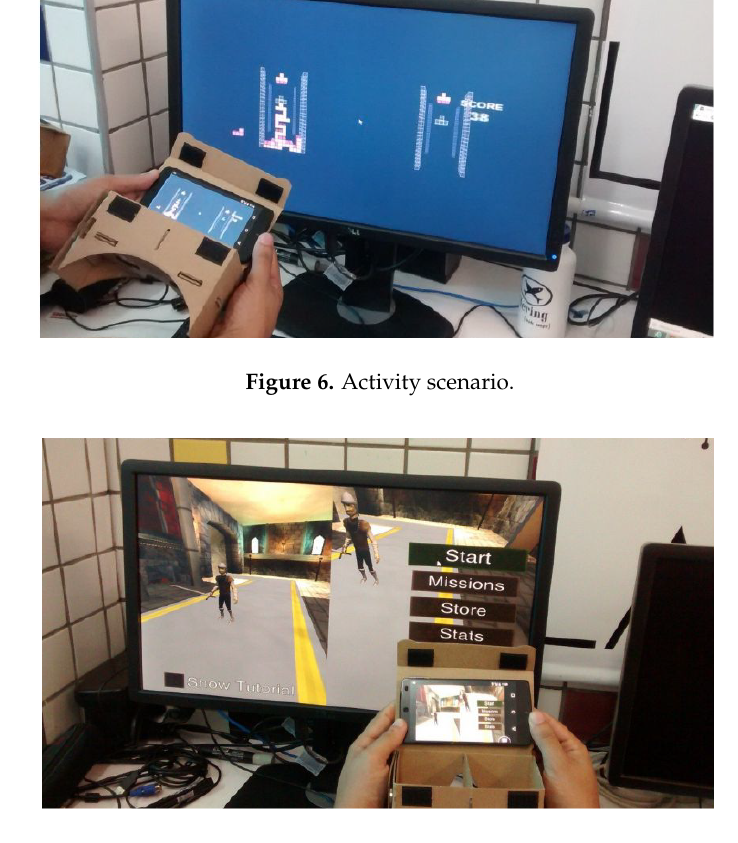
Figure 7. Activity